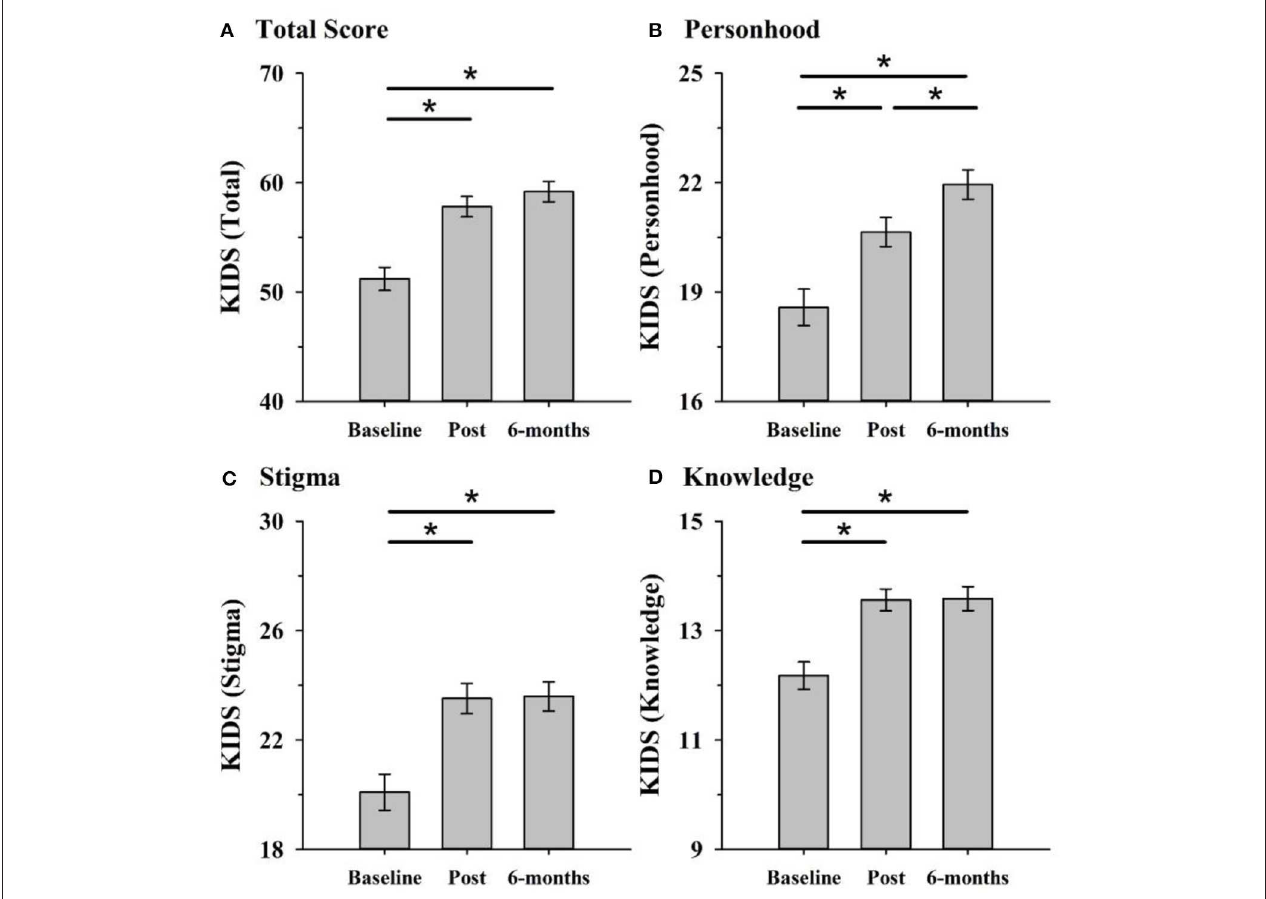
FIGURE 1 | KIDS scores improved in both excursion and non-excursion classes after the program compared to before. Improvements were maintained at 6-months follow-up and occurred across the total score (A) and each of the three factors personhood (B) , stigma (C) , and knowledge (D) . * p < 0.05 (after Bonferroni correcting for multiple